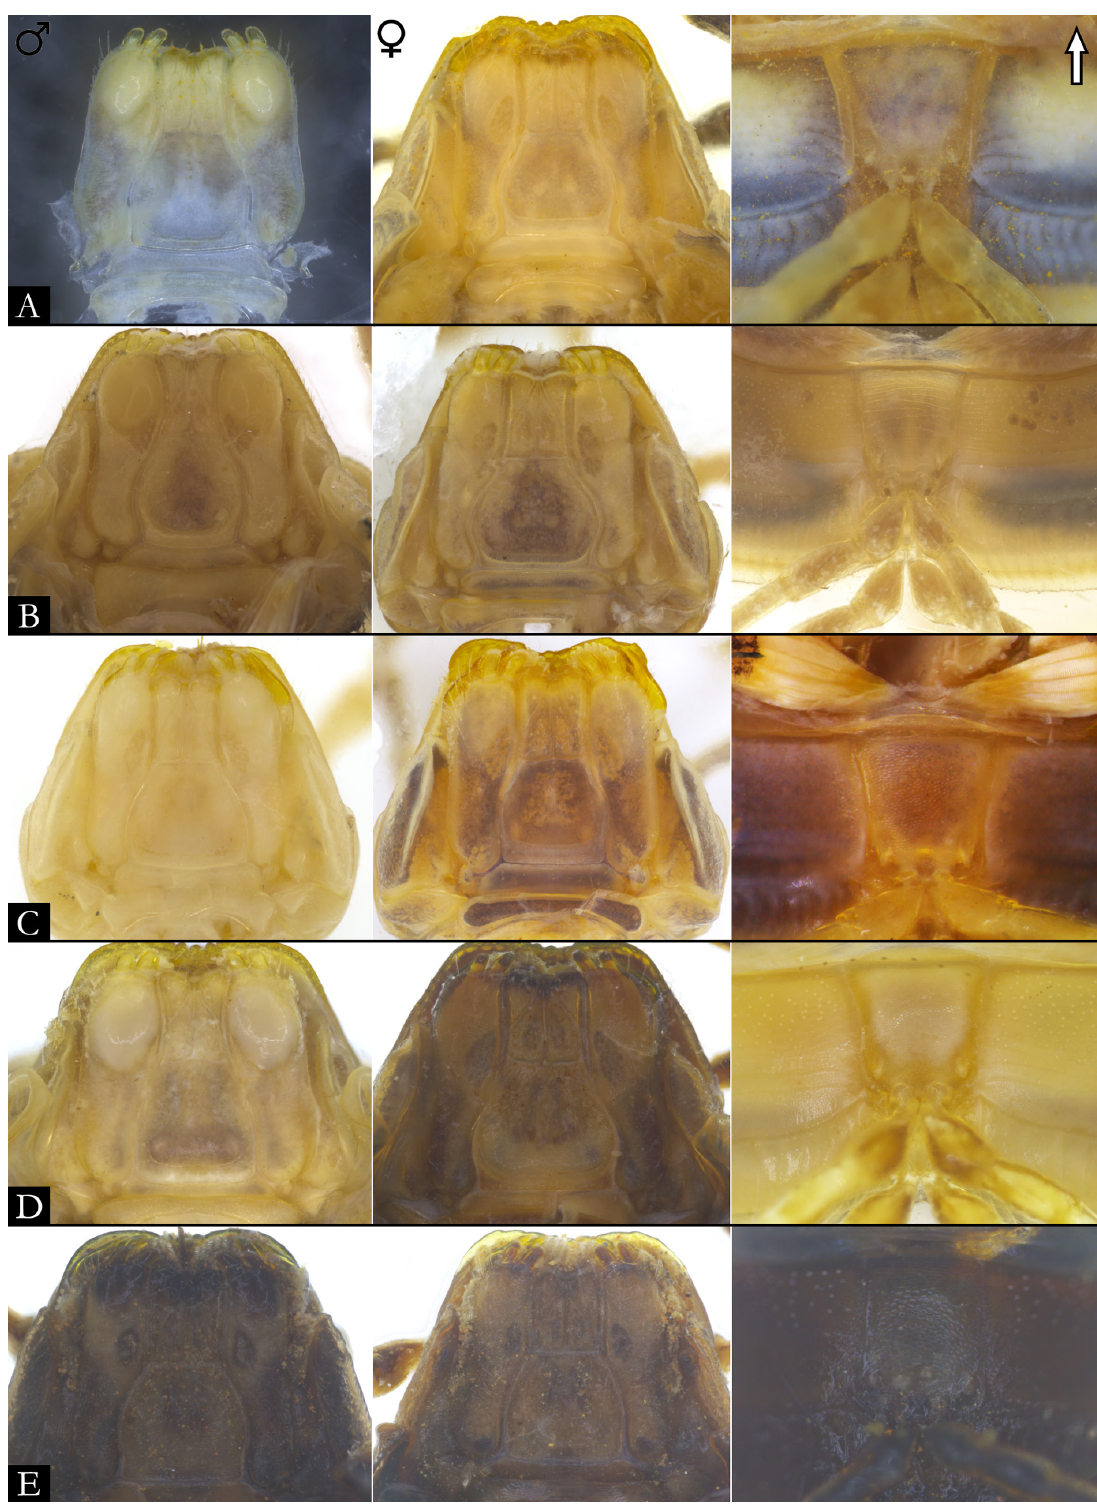
Fig. 172. Stereoscopic images of gnathochilarium and anterior sternum of species of